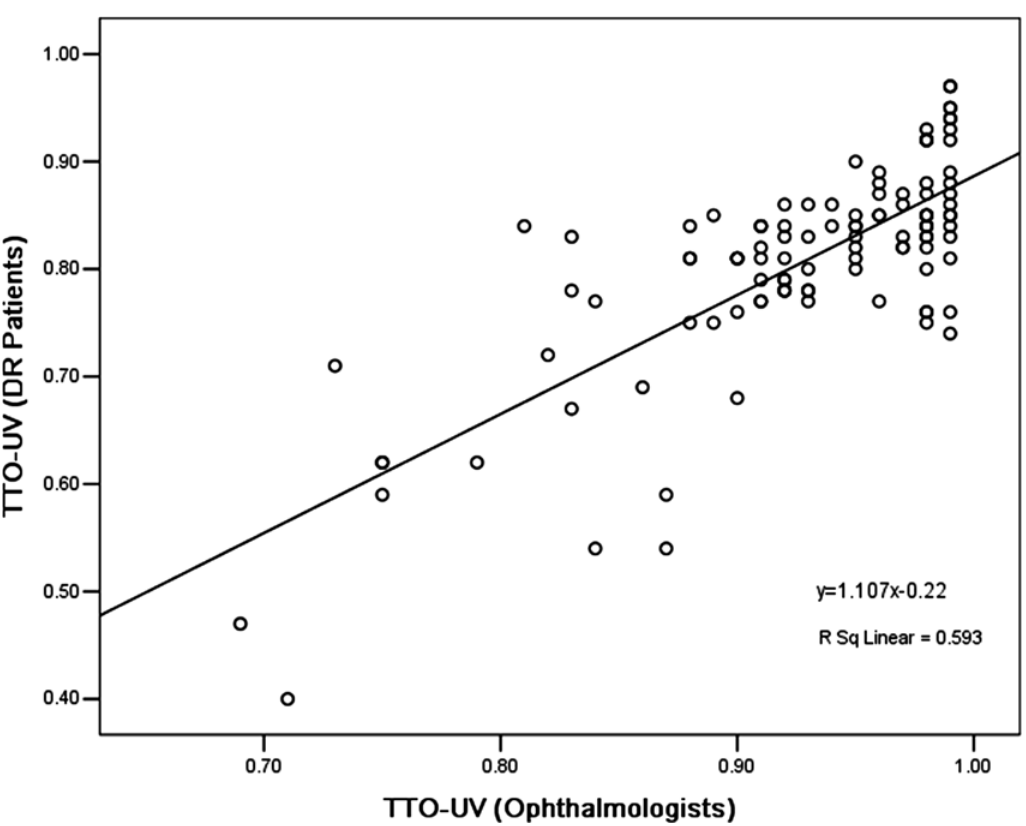
Fig 2. Scatter dot-plots of utility values from diabetic retinopathy patients and ophthalmologists, using the time trade-off